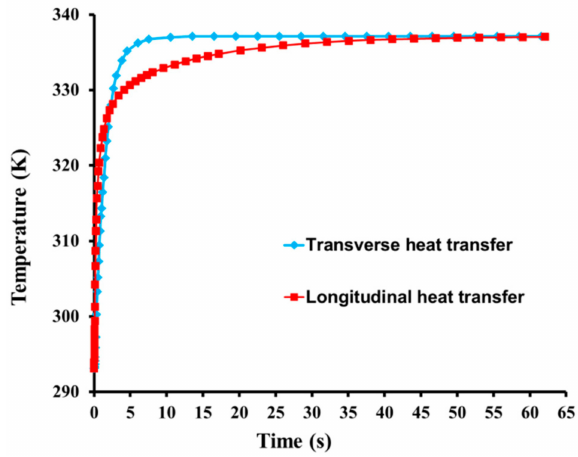
Figure 16. Temperature as a function of time during transverse and longitudinal heat transfer.